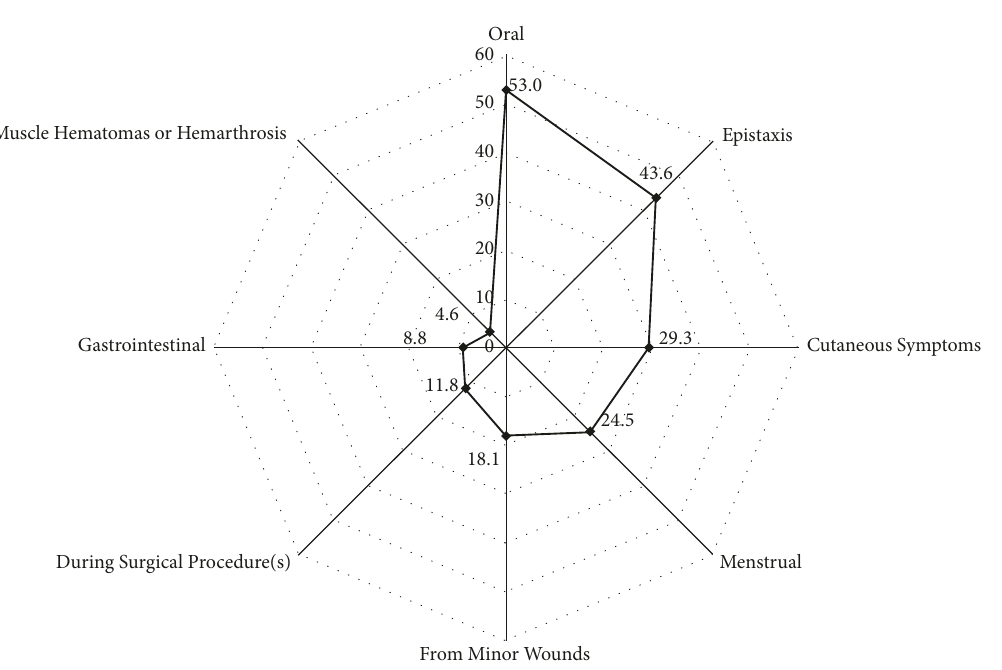
Figure 1: Prevalence of bleeding symptoms as reported by the